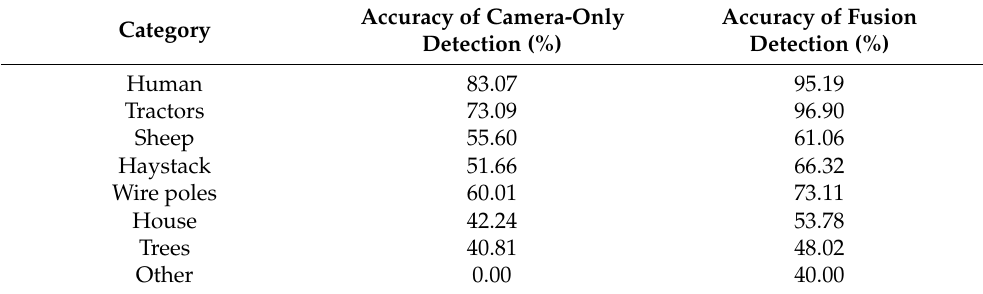
Table 5. Comparison of single sensor and multi-sensor detection results on all kinds of obstacles.